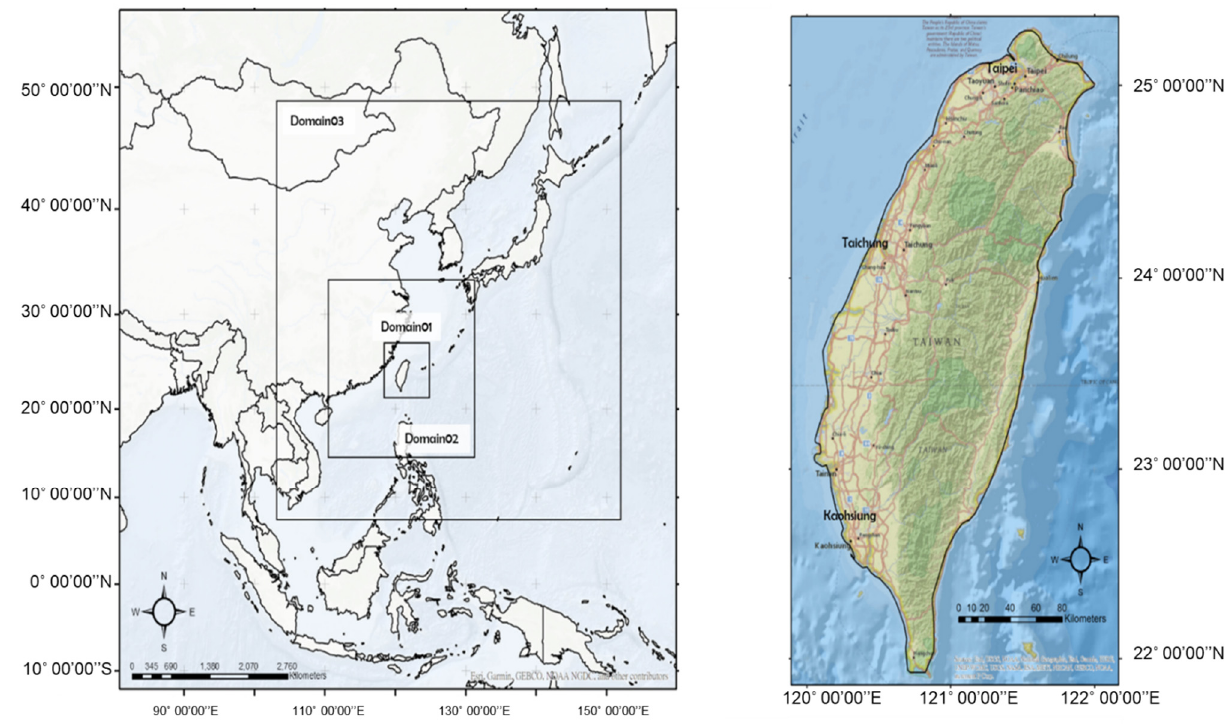
Figure 1. The simulation domain and setting.